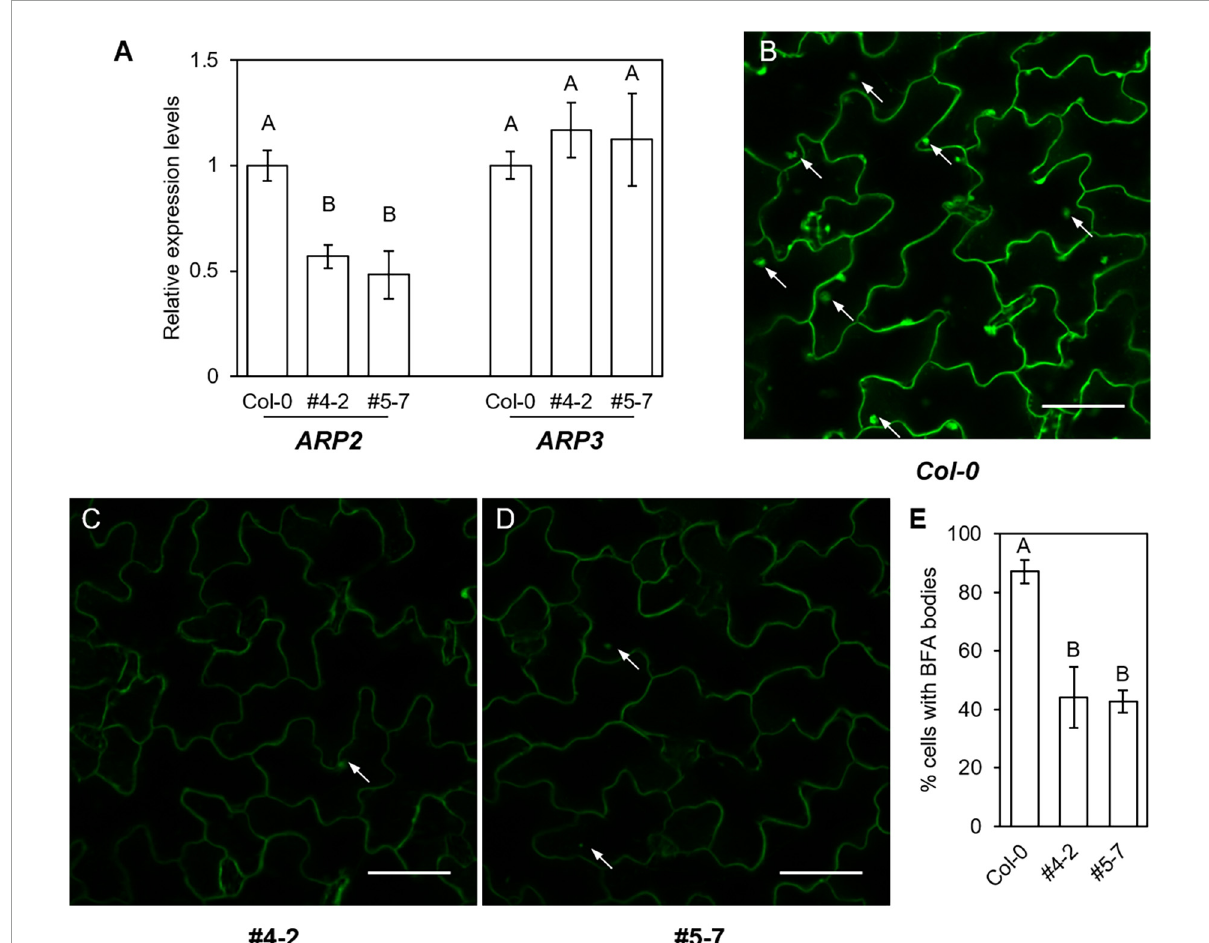
FIGURE7 Intracellular trafficking of GFP-PEN1 proteins in CRISPR-edited stable transgenic lines. (A) Relative gene expression levels of ARP2 and ARP3 at indicated lines expressing GFP-PEN1. Relative expressions were calculated based on the expression of Col-0 expressing GFP-PEN1 lines, the expression of Actin2 is used as the internal control. Four biological replicates were used for each genotype. (B–D) Intracellular aggregation of GFP-PEN1 after BFA treatment in GFP-PEN1 expressing Col-0 (B) , ARP2 CRISPR-edited stable lines #4-2 (C) and #5-7 (D) . BFA bodies were imaged after 60 min 50 µ M BFA treatment and indicated by arrows. Bars, 40 µ m. (E) Percentage of cells showing intracellular accumulation of BFA bodies in indicated lines. At least 300 cells were applied for each genotype. Different letters in panels (A,E) indicate statistically significant differences determined by one-way ANOVA with Tukey’s HSD ( p <